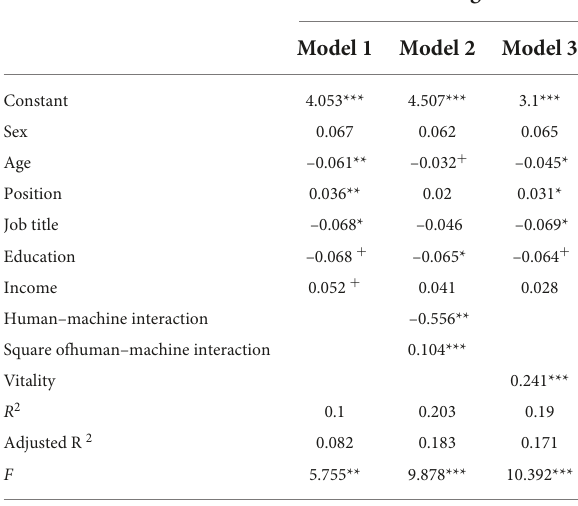
TABLE 4 Results of regression